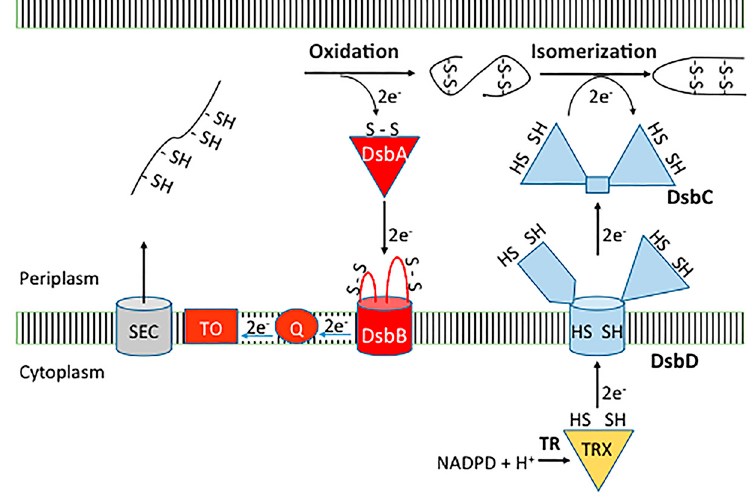
Figure 1. Escherichia coli K-12 disulfide catalytic pathways. In the oxidase pathway the thioredoxin-like oxidase DsbA introduces disulfide bonds into proteins that are translocated to the periplasm via the SEC machinery (the plotted line with the -SH and S-S symbols represents the amino acid chain of the DsbA substrate protein). Upon oxidising a substrate, DsbA becomes reduced and is re-oxidized by the partner membrane protein DsbB, which transfers electrons to quinones (Q) and terminal oxidases (TO). In the isomerase pathway, incorrectly formed disulfide bonds are corrected by the isomerases DsbC and DsbG, which are maintained in a reduced form by the inner membrane reductase DsbD. This multidomain protein is reduced by cytoplasmic thioredoxin, which in turn is reduced by thioredoxin reductase (TR) in a NADPH-dependent manner.